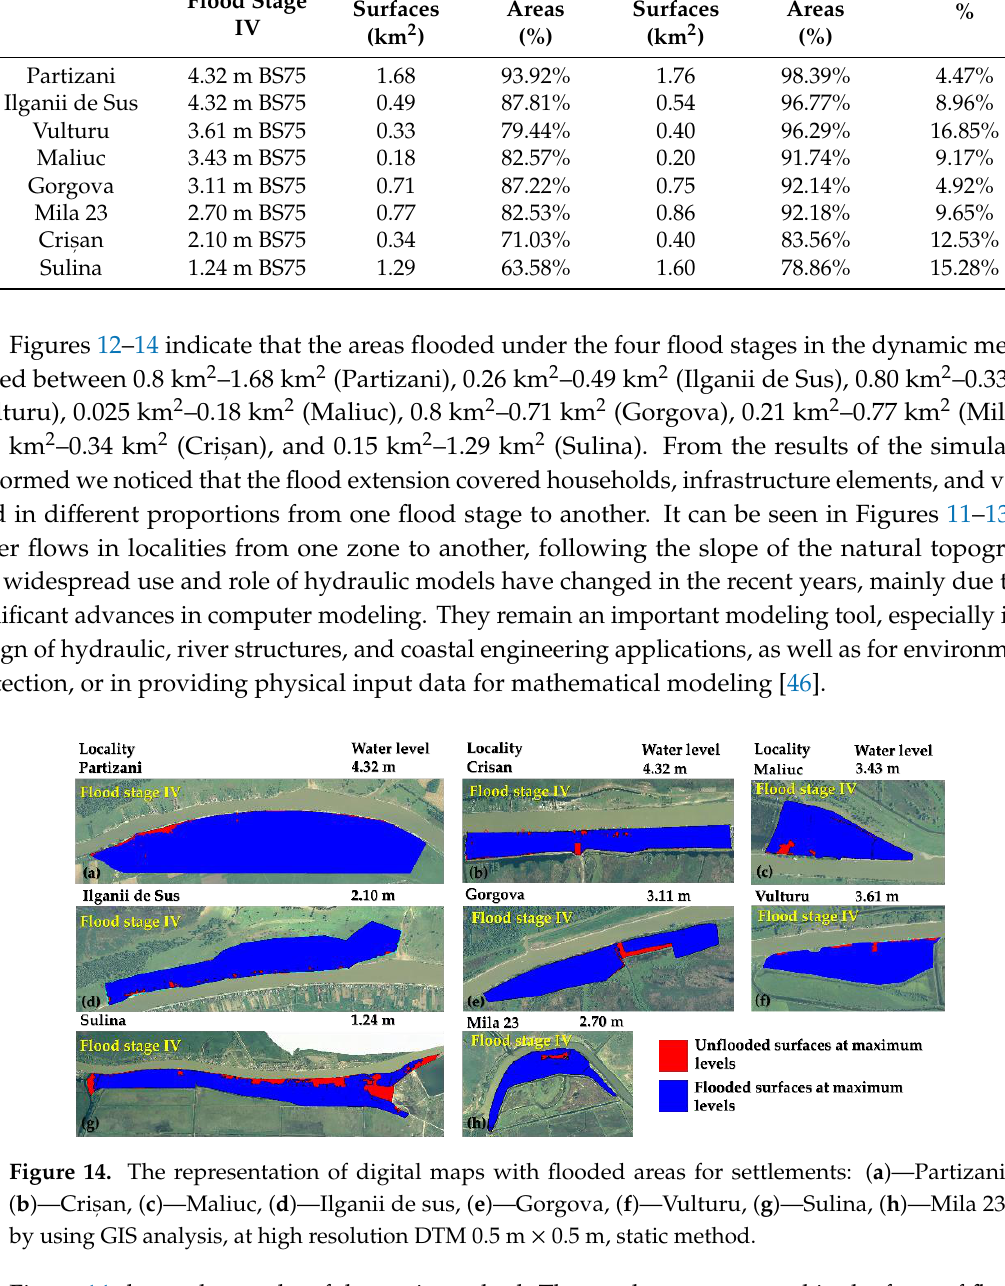
Table 5. The flooded areas of the settlements analyzed at the flood stage IV: maximum water level of the Danube.